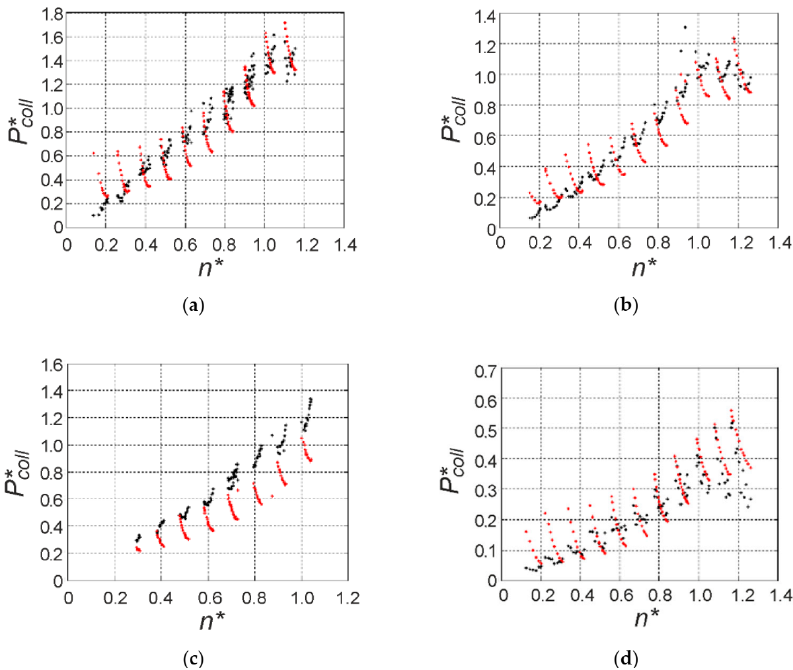
Figure 6. Tested (black) P ∗ and estimated (red) collective losses P ∗ t coll speed n * for: ( a ) motor 1, ( b ) motor 2, ( c ) motor 3, ( d ) motor 4 (Table